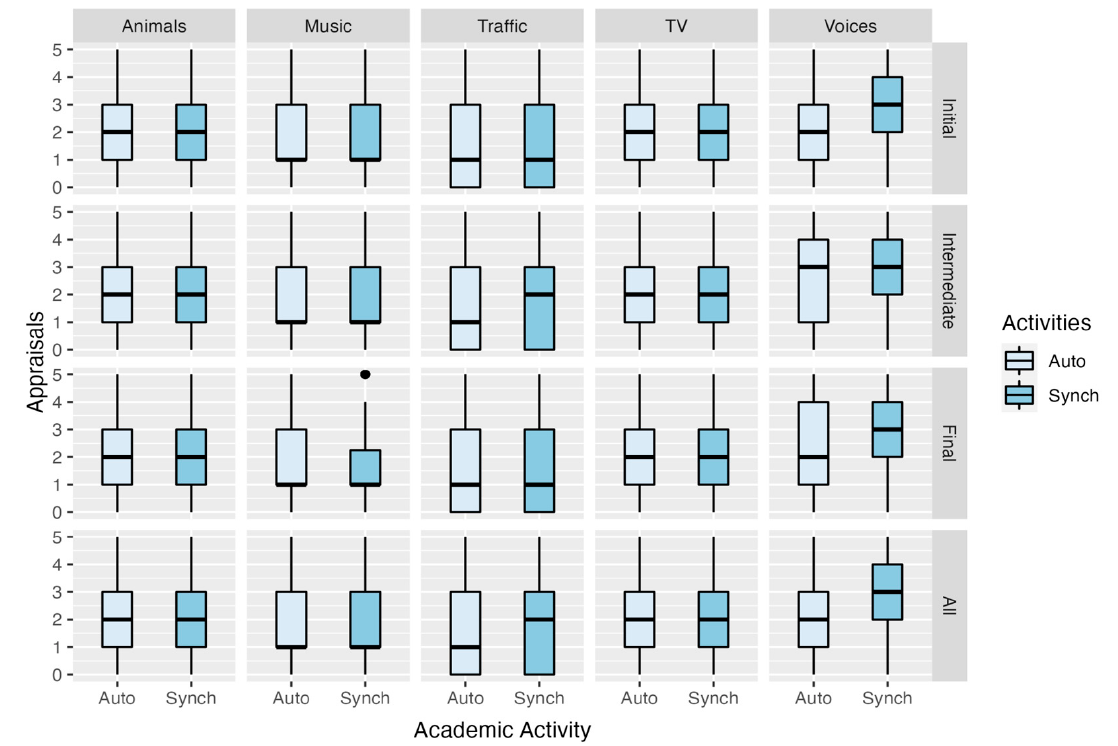
Figure 4. Box plot of the responses given to the degree of interference from different noise sources (‘Animals’, ‘Music’, ‘Traffic’, ‘TV/Radio/Household Appliances’, and ‘Voices’) with regard to stu- dents’ engaging in autonomous (Auto) and synchronous (Synch) activities, split by the ‘current se- mester’ (semester in which the survey was conducted).